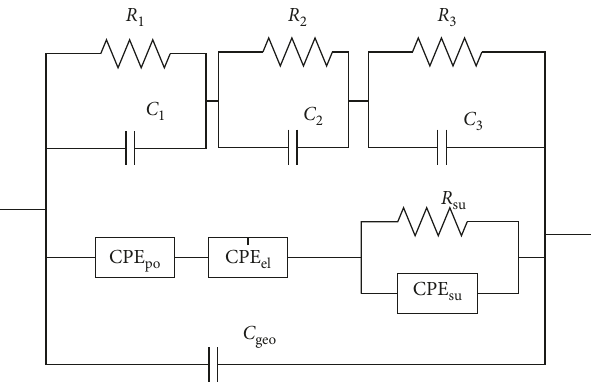
Figure 7: Proposed equivalent circuit for the sensors.